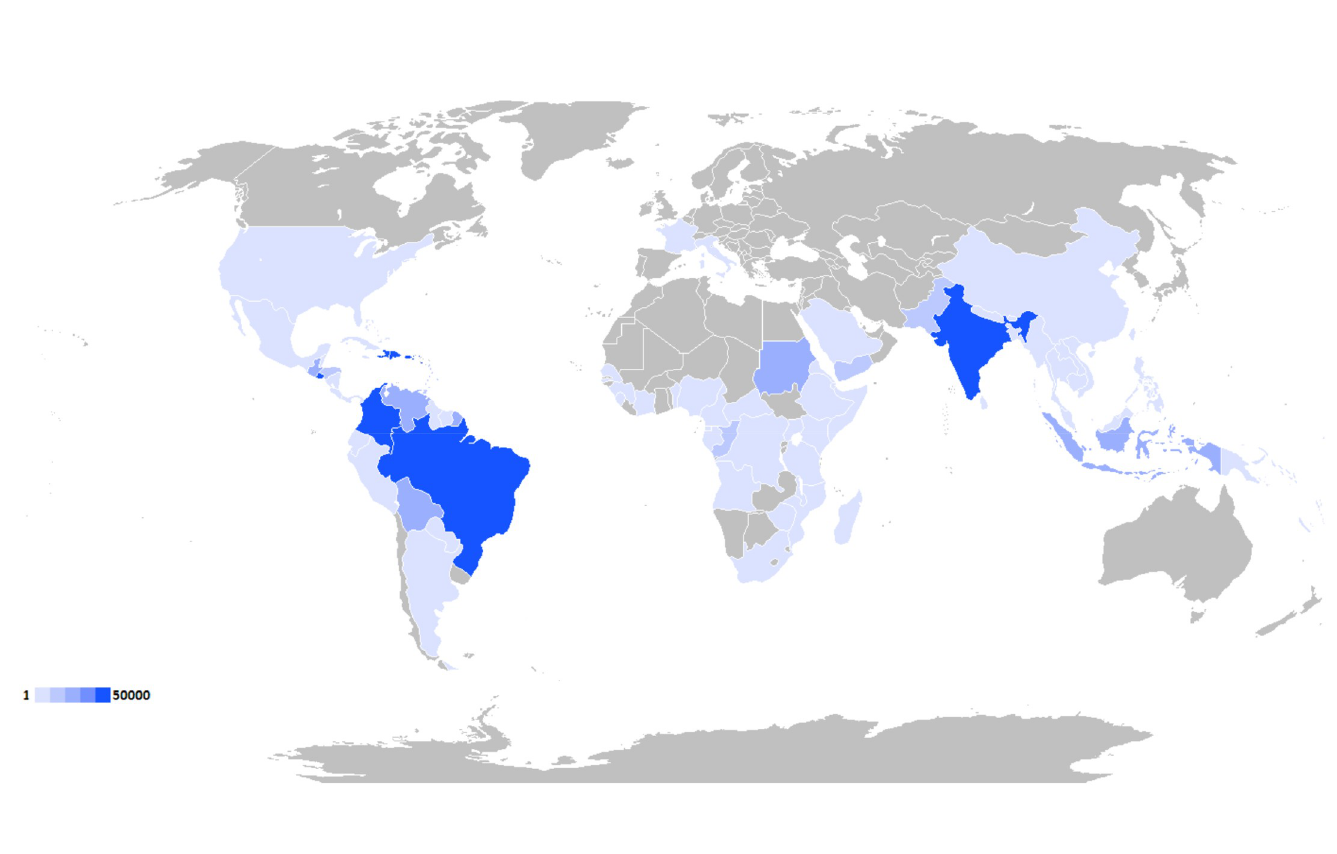
Fig 2. Global distribution of CHIKV. Countries having transmission of chikungunya, with gradient indicating average number of reported cases per year from 2010 to 2019. Map created using an open-access world map from Wikimedia Commons (https://commons.wikimedia.org/wiki/File:BlankMap-World.svg). CHIKV, chikungunya